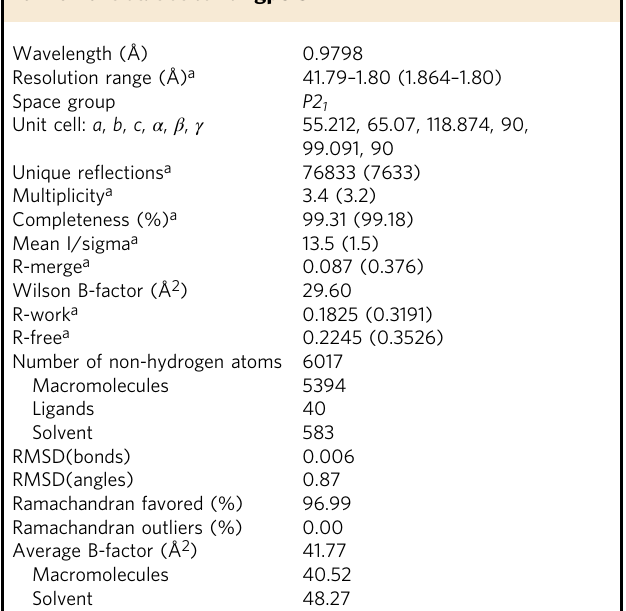
Table 1 X-ray crystallographic data collection and re fi nement statistics for